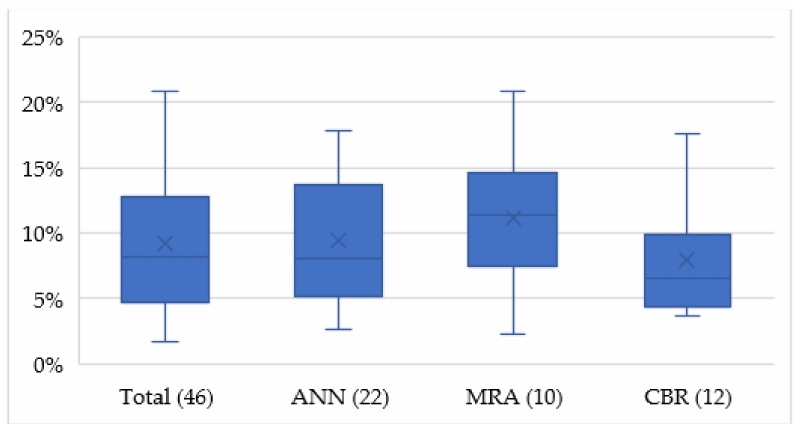
Figure 4. Box and whiskers chart of the average MAPE by